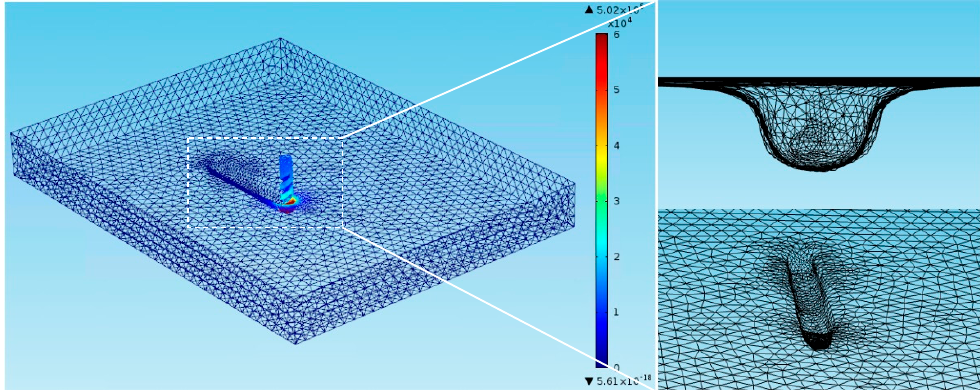
Figure 4. Distribution of electric field intensity in the machining gap when machining time is 30 min.